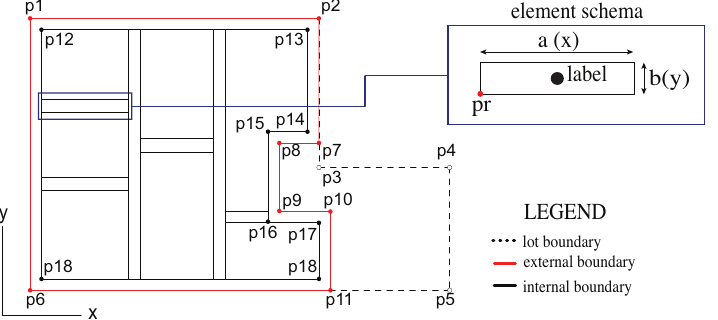
Figure 4. Abstract schema for defining the data input for the floor plan configuration (adapted from